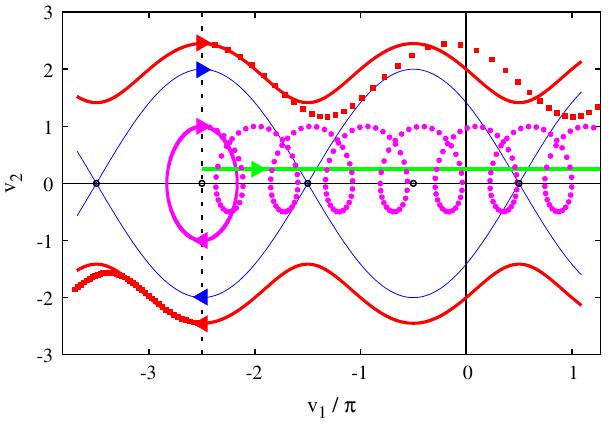
FIG. 2. Phase plane orbits on resonance ( a ¼ 0 : solid magenta, blue, red curves, and five black fixed points) and NearR ( a ¼ 1 = 2 : green solid and dotted magenta and red curves). k ¼ 1 , A ¼ 2